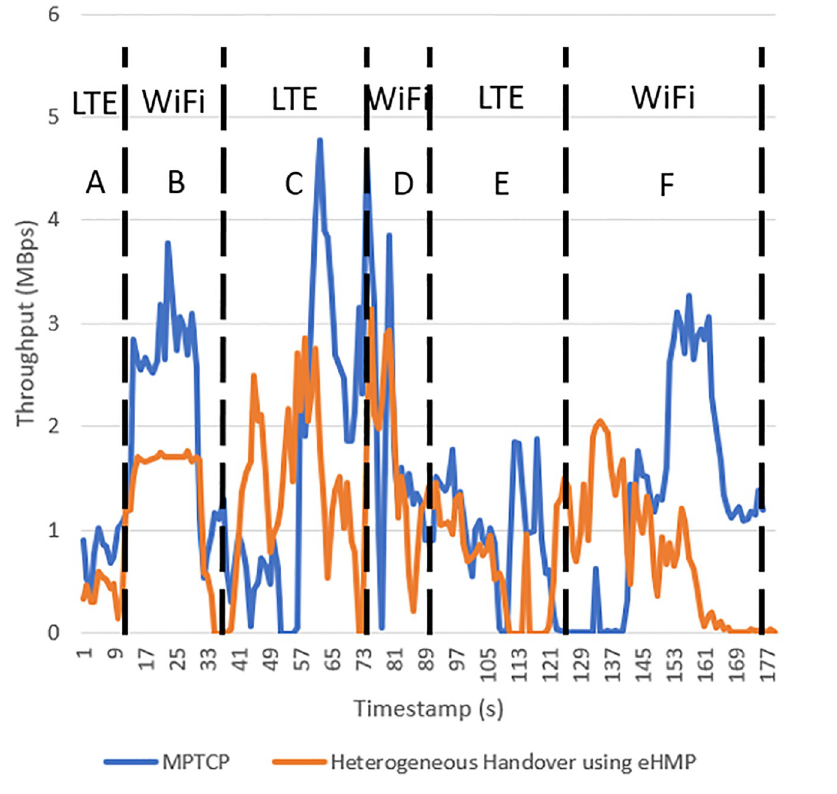
Fig 29. Network throughput of MPTCP and heterogeneous handover using eHMP.